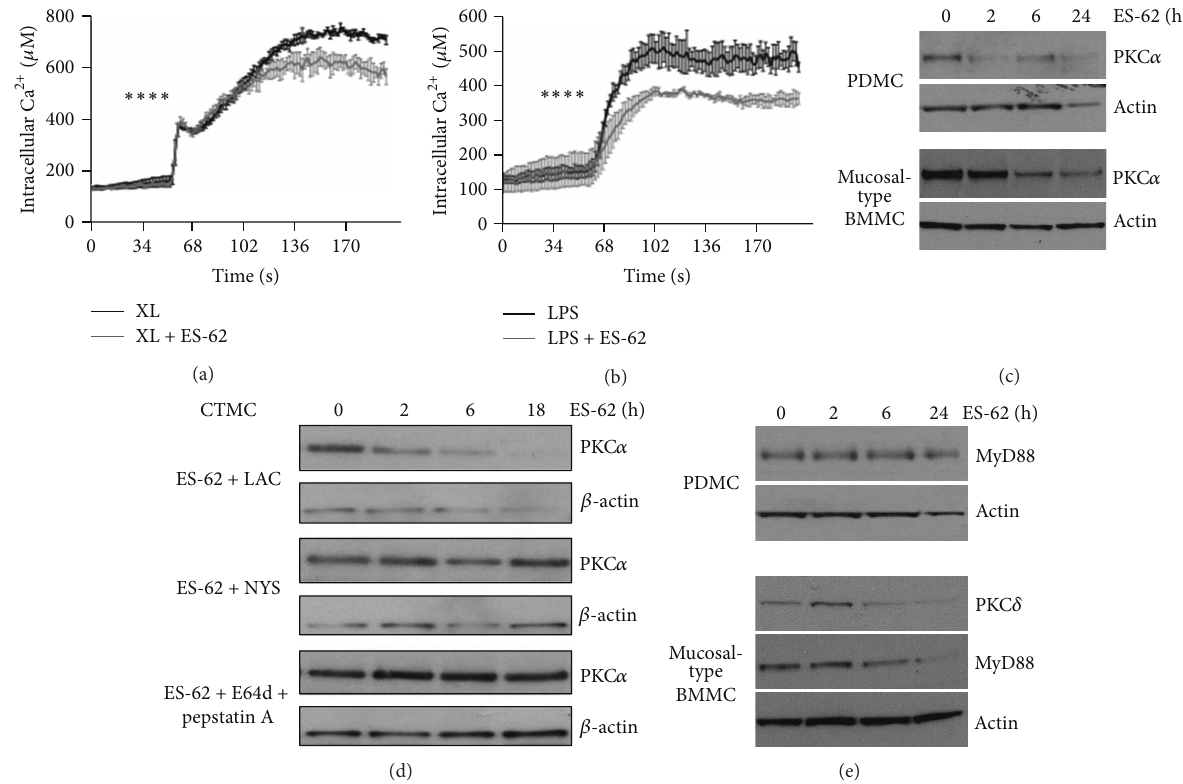
Figure 5: ES-62 modulates signalling in mast cell subsets. PDMC were sensitised with murine anti-DNP IgE (0.5 𝜇 g/mL) in the presence or absence of ES-62 (2 𝜇 g/mL) overnight. Following loading with Fura-2/AM such PDMC were stimulated at 50s with DNP (0.5 𝜇 g/mL) to induce cross-linking (XL) of Fc 𝜀 R1 (a) or 0.5 𝜇 g/mL LPS (b) and intracellular calcium mobilisation and influx recorded in real time using excitation-emission ratios of 340/380 nm (a) & (b). Calcium levels were calculated from 𝑅 max and 𝑅 min values and data are presented as the mean calcium values of triplicate samples from a single experiment representative of at least 3 independent experiments. PDMC and mucosal-type BMMC (c) & (e) were cultured with ES-62 (2 𝜇 g/mL) for the indicated times and expression of PKC 𝛼 ((c), Cell Signalling Technology), MyD88 ((e), Abcam) and PKC 𝛿 ((e), Cell Signalling Technology) analysed by Western Blotting. In (d), following preincubation for 1h with inhibitors of proteosomal degradation (10 𝜇 M Lactacystin, ENZO Life Sciences; LAC), caveolae/lipid raft trafficking (50 𝜇 g/mL Nystatin; NYS) and lysosomal degradation (E64d + pepstatin A both 10 𝜇 g/mL, ENZO Life Sciences), sensitised CTMC were cultured with ES-62 (2 𝜇 g/mL) for the indicated times and expression of PKC 𝛼 analysed by Western Blotting. Actin was used as a loading control and ES-62-mediated downregulation of PKC 𝛼 expression was observed in PDMC, Mucosal-type BMMC, and CTMC in at least 2 independent